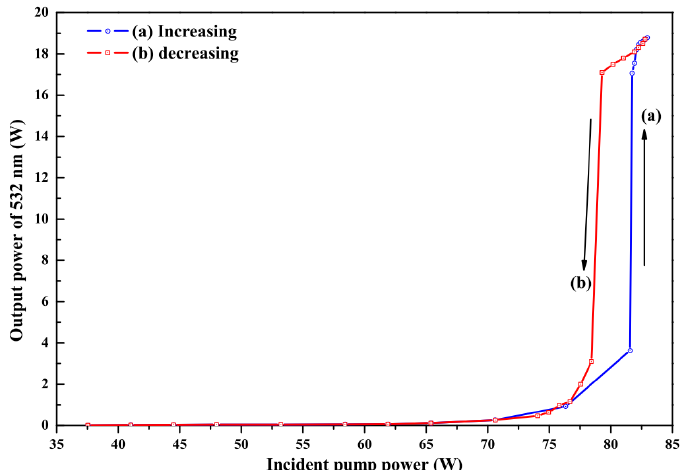
Figure 8. Output power of the 532 nm laser in the cases of ( a ) increasing and ( b ) decreasing the incident pump power with the bistability-like phenomenon [26]. Reprinted with permission from [26] c (cid:13) The Optical Society.